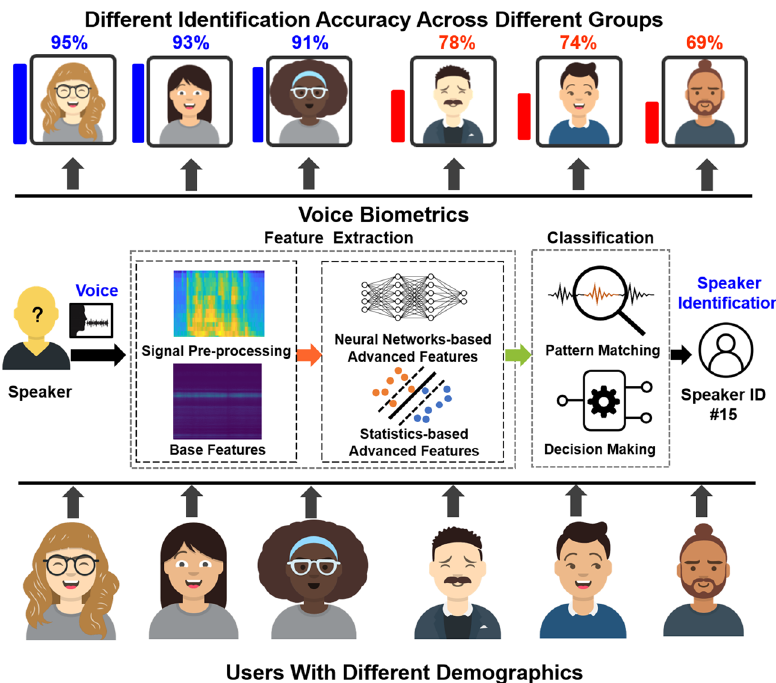
Figure 1. These voice biometric services could produce significantly different identification results towards speakers with diverse demographic